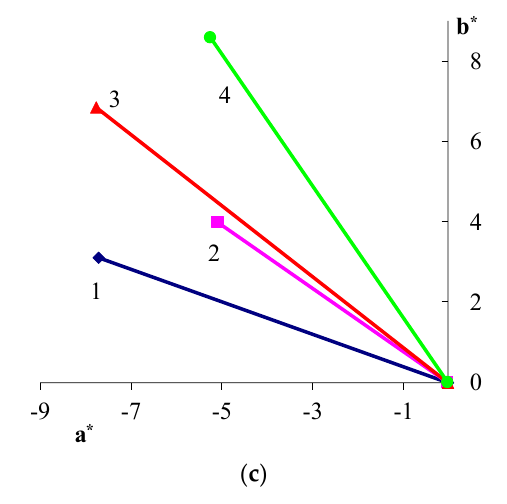
Figure 8. Color vector projection of core/shell pigment based on talc and doping acid: ( a ) H 2 SO 4 ; ( b ) HCl; ( c ) H 3 PO 4 ; ( d ) undoped PANi on the CIEL*a*b* color plane. PANi content in the core/shell pigment (wt.%): (1)—5; (2)—20; (3)—33; (4)—50. Hiding power is another important optical property of pigment. This property, for PANi-coated core/shell pigments, depends on the polymer content in the pigment only and has no relation to the doping acid used in the synthesis. Core/shell pigment hiding power grows with an increase in PANi content (Figure 9). It should be noted that the hid- ing power is comparable to that of pure PANi, even at a 50 wt.% of core/shell pigment content, with a shell of phosphoric-acid-doped PANi.